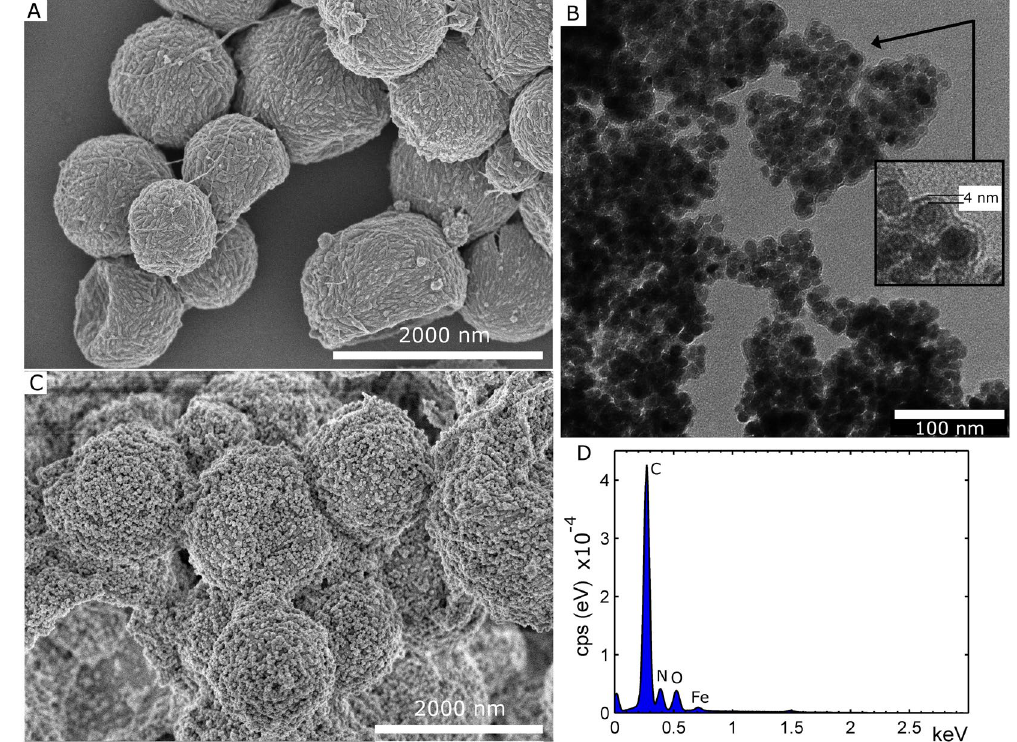
Figure 4. SEM images of magnetic capsules, both precursor capsules ( A ) and after growth of the SiO x nanoparticles ( C ). The capsules contained surface modified SPION. ( B ) TEM image of coated SPION nanoparticles. The nanoparticles were coated with a 4 nm thick OTES coating, rendering their surface hydrophobic. ( D ) The EDS spectrum for the (precursor) capsules in ( A ). The presence of Fe, due to SPION nanoparticles, is evident. The EDS spectrum for capsules in ( C ) is found in Figure S7 in